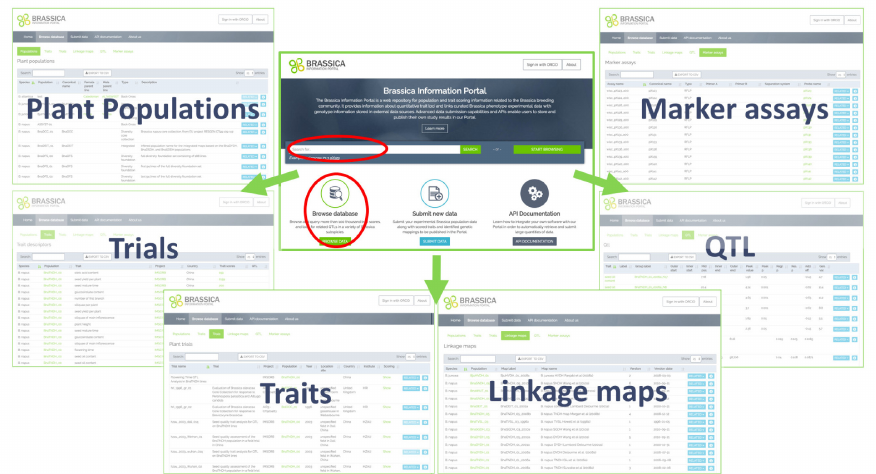
Figure 2. Access to the database via the web interface is possible either by global search across all indexed database fields (upper red circle), or through targeting specific content/tables by following the link on “Browse database” (lower red